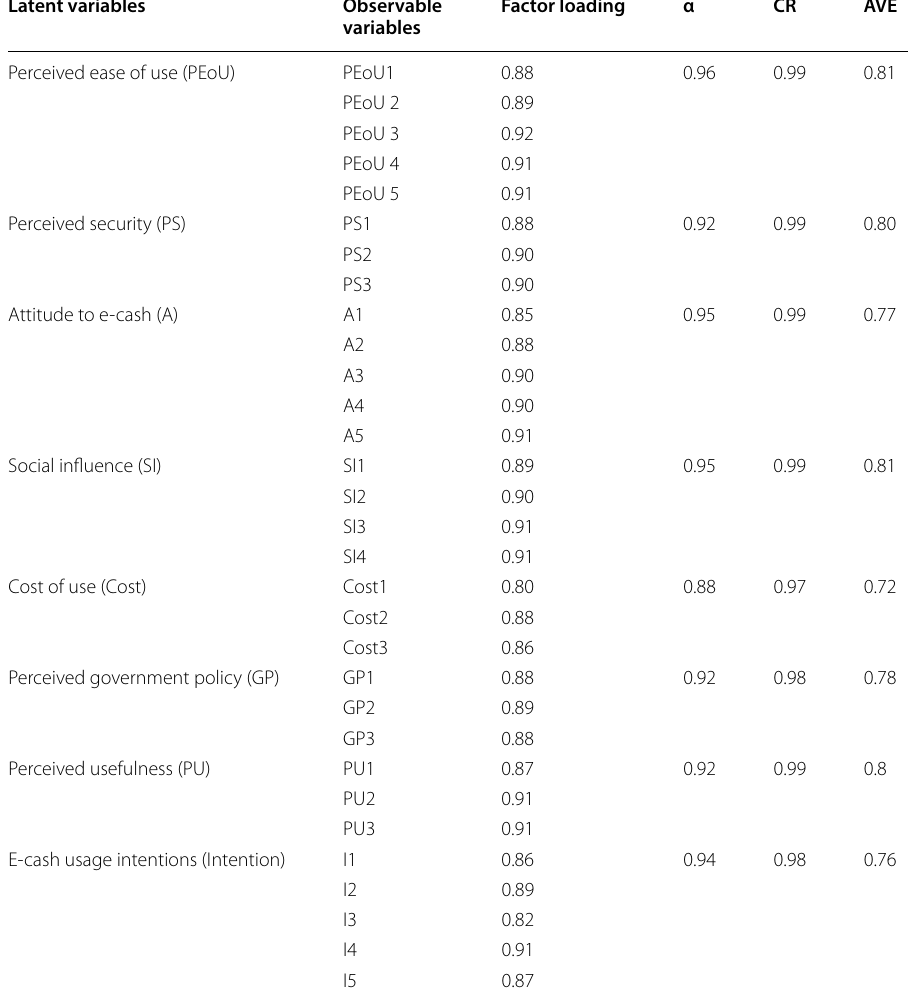
Table 4 The reliability and validity of the measurement